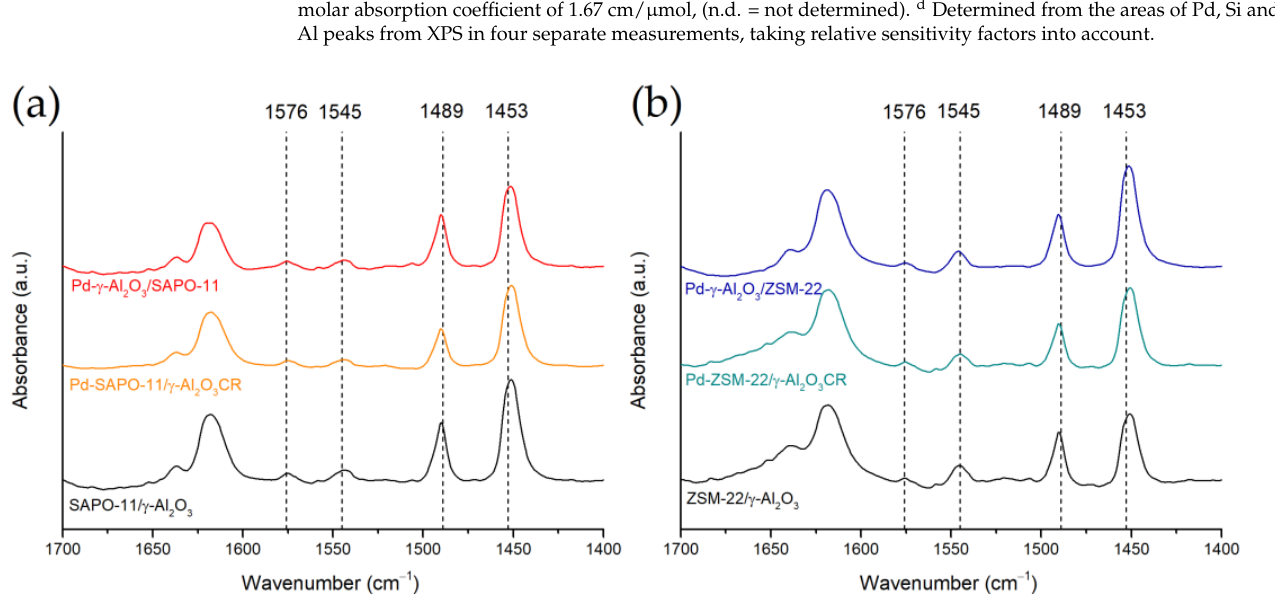
Figure 1. FT-IR spectra of the ( a ) SAPO-11 catalysts and ( b ) ZSM-22 catalysts after pyridine adsorption and subsequent desorption at 250 °C.